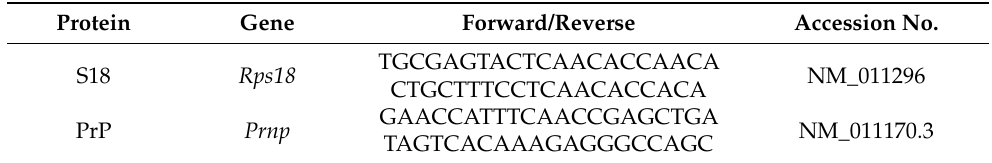
Table 3. Oligonucleotide primers used for real-time PCR.